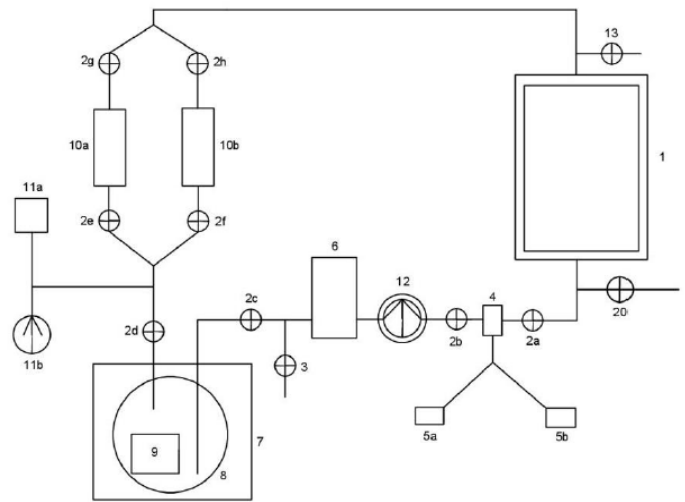
Figure 1. Patented principle of a flow reactor with a microwave unit and / or catalytic bed, scheme taken from [59], inner arrangement of a modular reservoir is not shown. Annotations are as